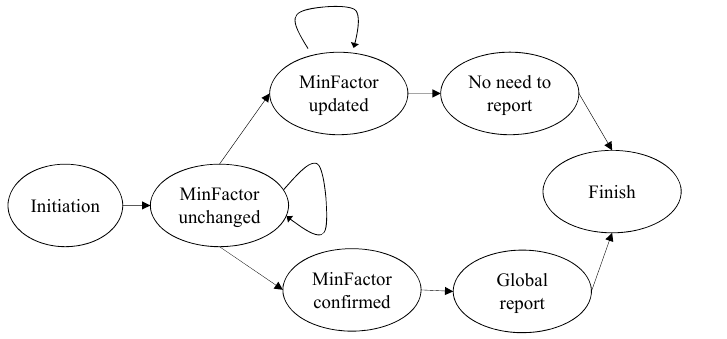
Figure 4. State machine at each vehicle that employs the proposed